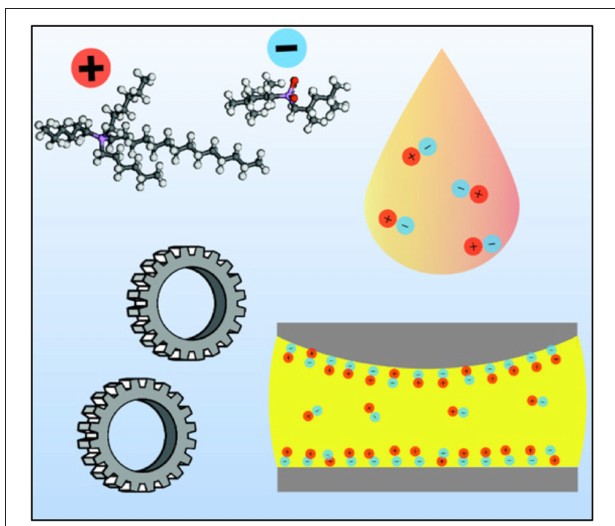
FIGURE 5 | Schematic of ionic liquid as a lubricant additive. Externally applied electric fields reposition the charged constituents within the confines of a contact. Reprinted with permission from Zhou and Qu